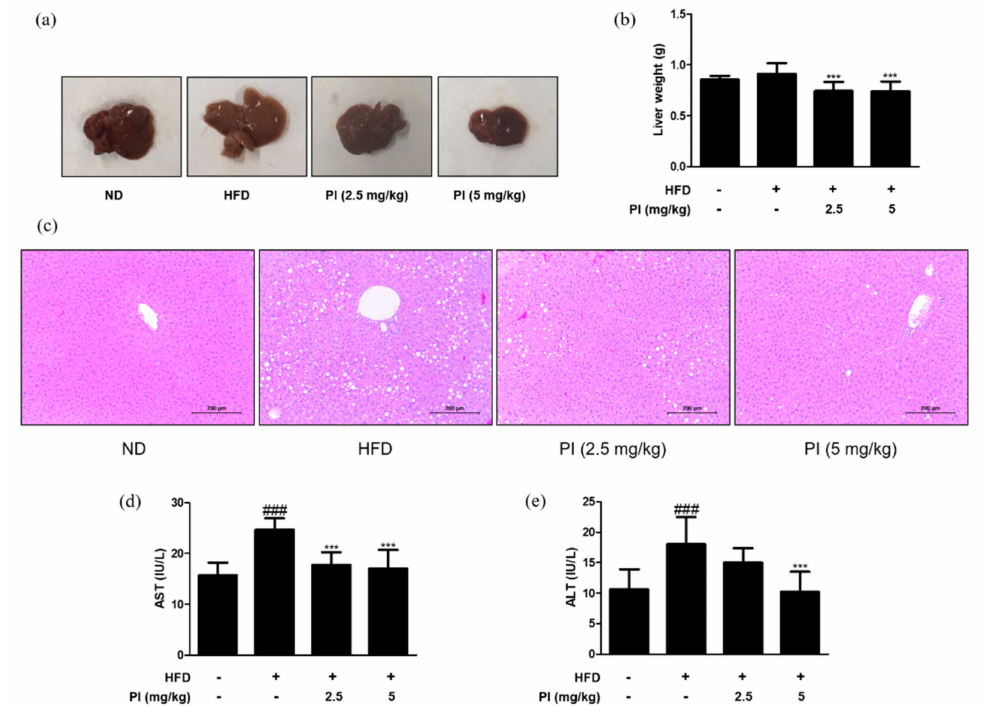
Figure 2. Effects of papain on liver steatosis in HFD–induced obese mice. ( a ) Macroscopic analysis of mouse liver tissue from different groups in HFD–induced obese mice. ( b ) Liver weight in HFD–induced mice. ( c ) Representative histological images of the liver tissue were assessed using H&E staining (original magnification; 200 × ). The liver tissue from representative mice in each group was fixed, embedded in paraffin, and stained with H&E. ( d ) Serum levels of AST and ( e ) ALT in HFD–induced obese mice. The values are given as the mean ± SD ( n = 6). ### p < 0.001 vs. ND group; *** p < 0.001 vs. HFD